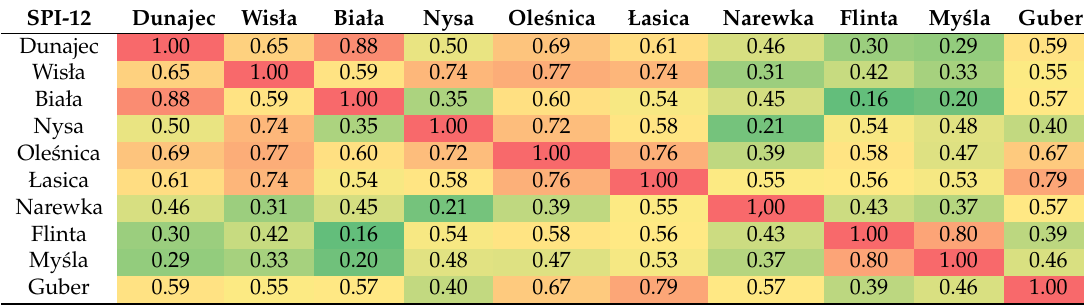
Table 4. Pearson correlation coefficient between SPI-12 in 1971-2000 estimated for ten studied catchments.